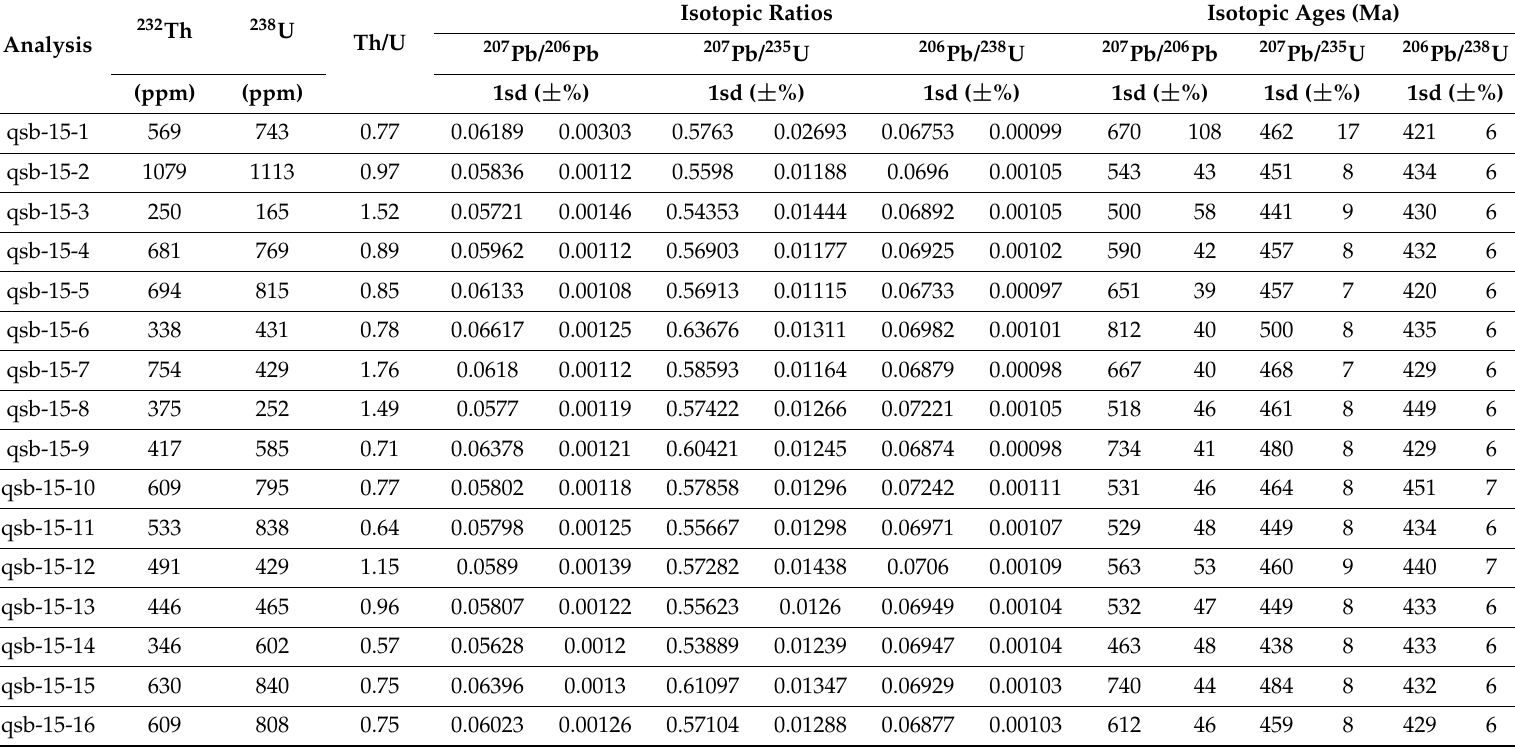
Table 7. Results of zircon U-Pb age analysis of the host magma (monzogranite) from the Qingshanbao